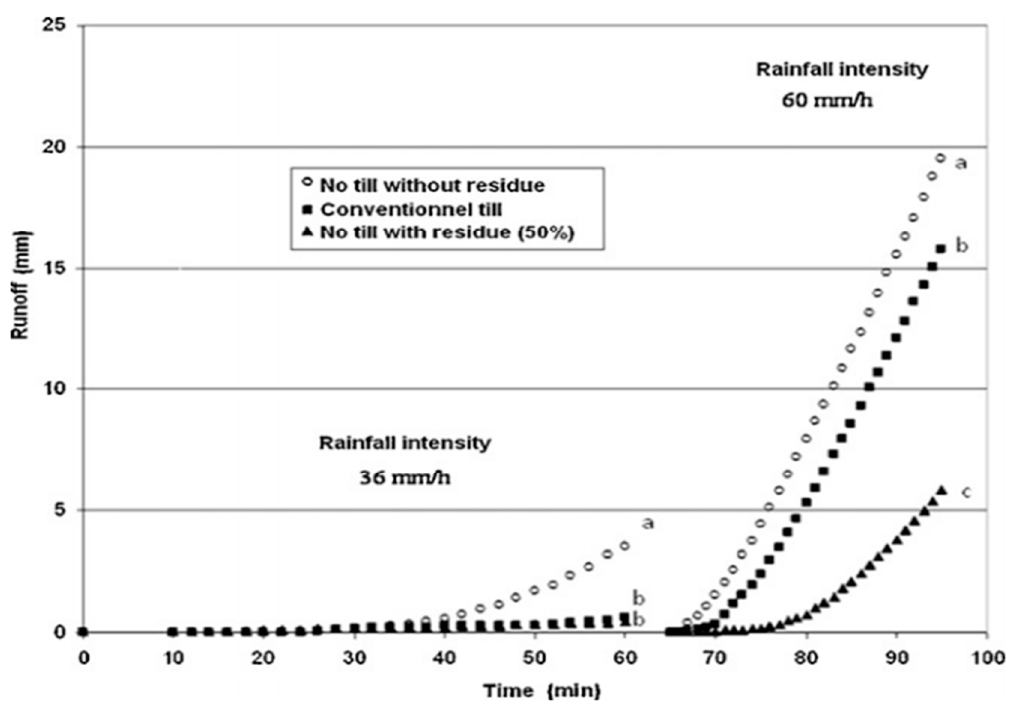
Figure 1. Runo ff loss as a ff ected by conventional tillage and no tillage with or without residue removal Figure 1. Runoff loss as affected by conventional tillage and no tillage with or without residue under two rainfall intensities in Zaers region removal under two rainfall intensities in Zaers region [22].